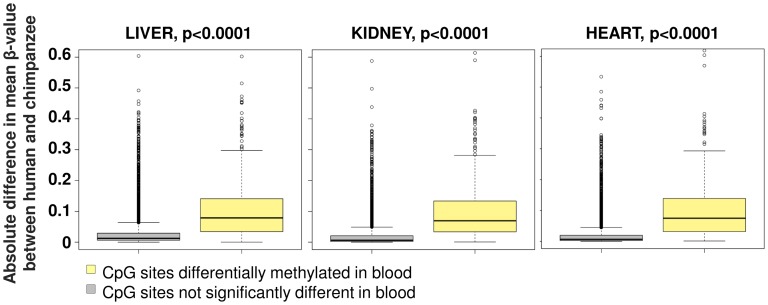
Conservation of human-chimpanzee differentially methylated sites among multiple somatic tissues.Differentially methylated sites we identified using whole blood of human and chimpanzee were compared to a previous study that used the Illumina HumanMethylation27 DNA Analysis BeadChip to study liver, kidney and heart tissue in an independent population of humans and chimpanzees [19]. We found a significant trend for sites that are differentially methylated in blood to also show higher human-chimpanzee divergence in these other tissues (yellow box plot, n = 457) suggesting a conservation across other somatic tissues compared to non-differentially methylated sites in blood (grey box plot, n = 7,942).